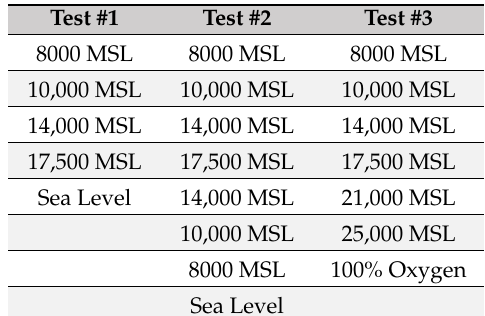
Table 1. Outline of reduced oxygen breathing device (ROBD) test altitudes. Each simulated altitude was maintained for 3 min, and all altitude changes were accomplished at a rate of 5000 feet per minute. There was a 20-min break between test #1 and 2 whereby subjects were breathing room air. The final descent “sea level” coincides with room air, while 100% oxygen was administered in test #3 following hypoxic